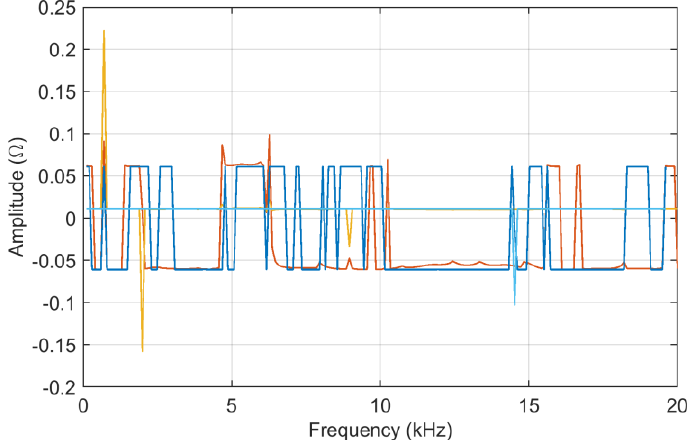
Figure 6. Z (45.0 km) and Z (45.5 km) input data in linear scale: skewness in dark color and kurtosis (offset around 0) in light color for ADM i (orange and yellow) and FDM i (blue and light blue).